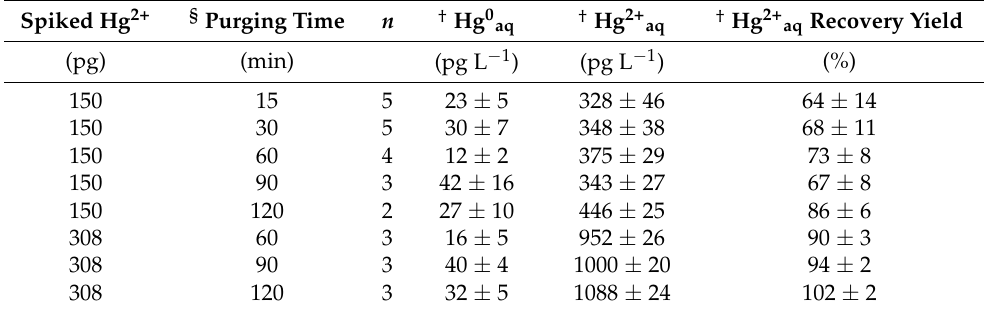
Table 1. Results of the extraction test with 150 pg or 308 pg SRM 8610 spiking in 290 mL pure water.